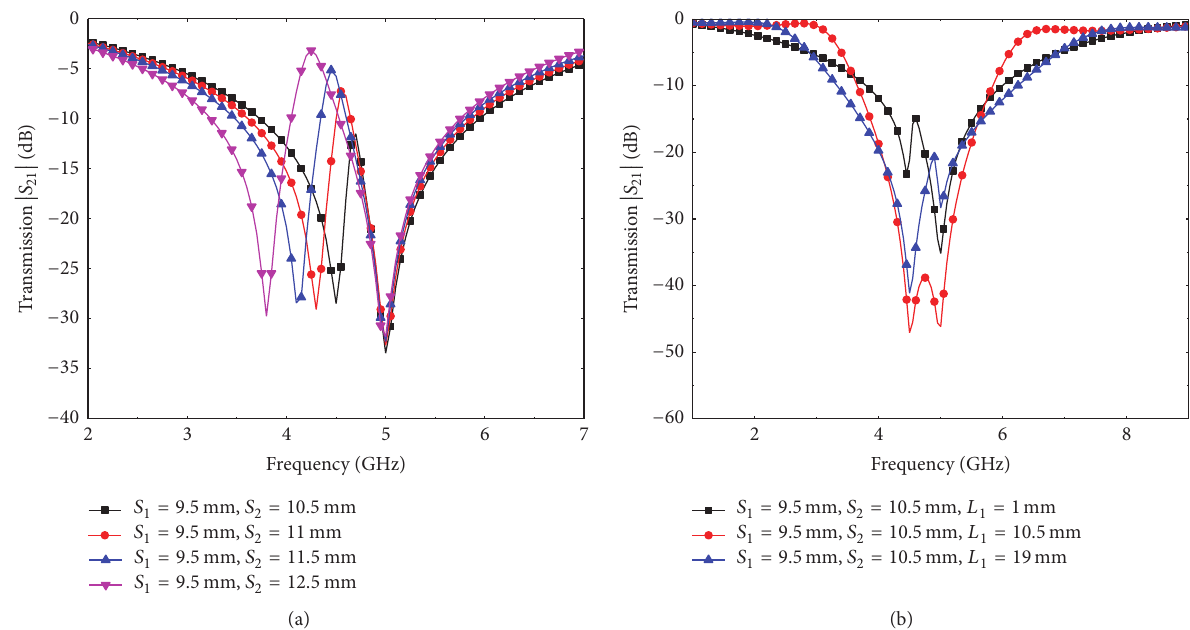
Figure 5: Transmission |𝑆 21 | properties of the double-stub structure with (a) various stub length 𝑆 2 and (b) various offset length 𝐿 1 .